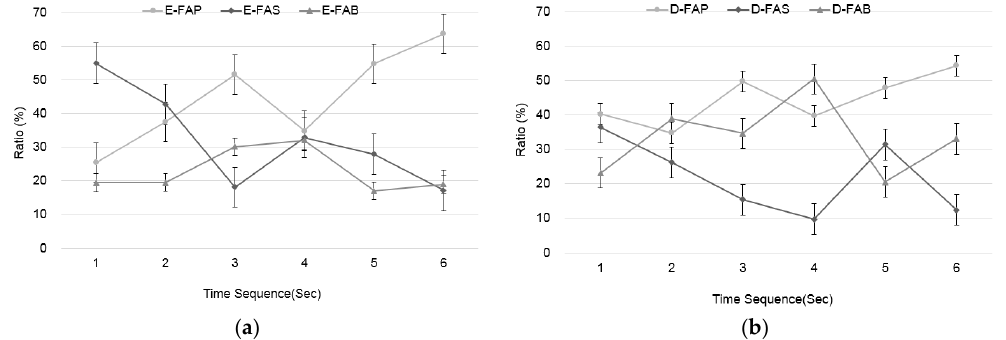
Figure 5. The extraction of the proportions of each AOI (path, sign, and background) from the entire area according to two groups. ( a ) The “easy” group’s gaze fixation on the AOI path (E-FAP), sign (E-FAS), and background (E-FAB) according to the time interval. ( b ) The “difficult” group’s gaze fixation on the AOI path (D-FAP), sign (D-FAS), and background (D-FAB) according to the time interval.